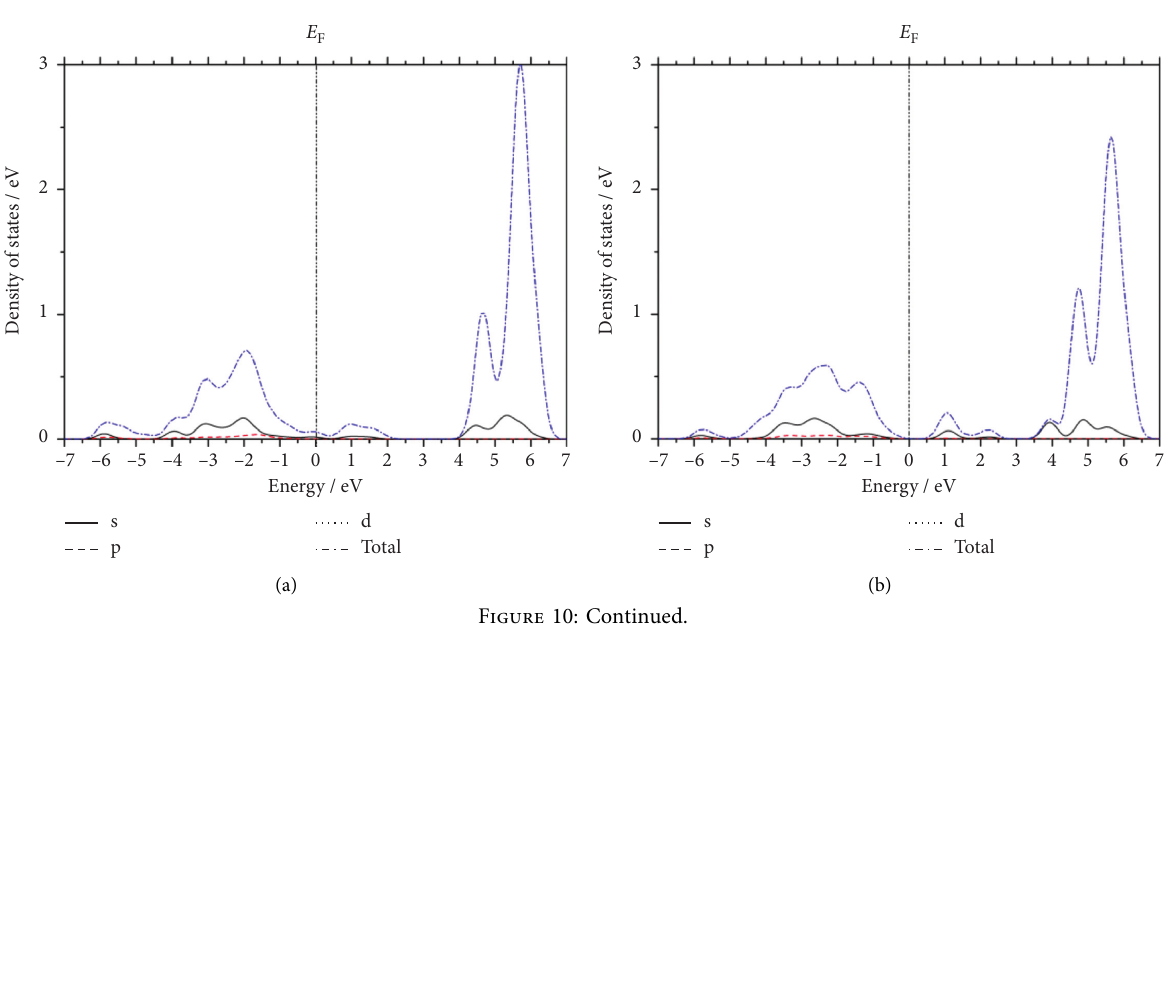
2 Co 2 O 5 crystalline oxide.